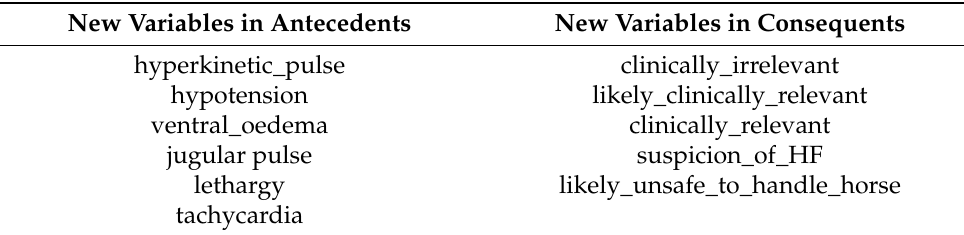
Table 2. Subsystem I (first level input data and conclusions/ask for more data).